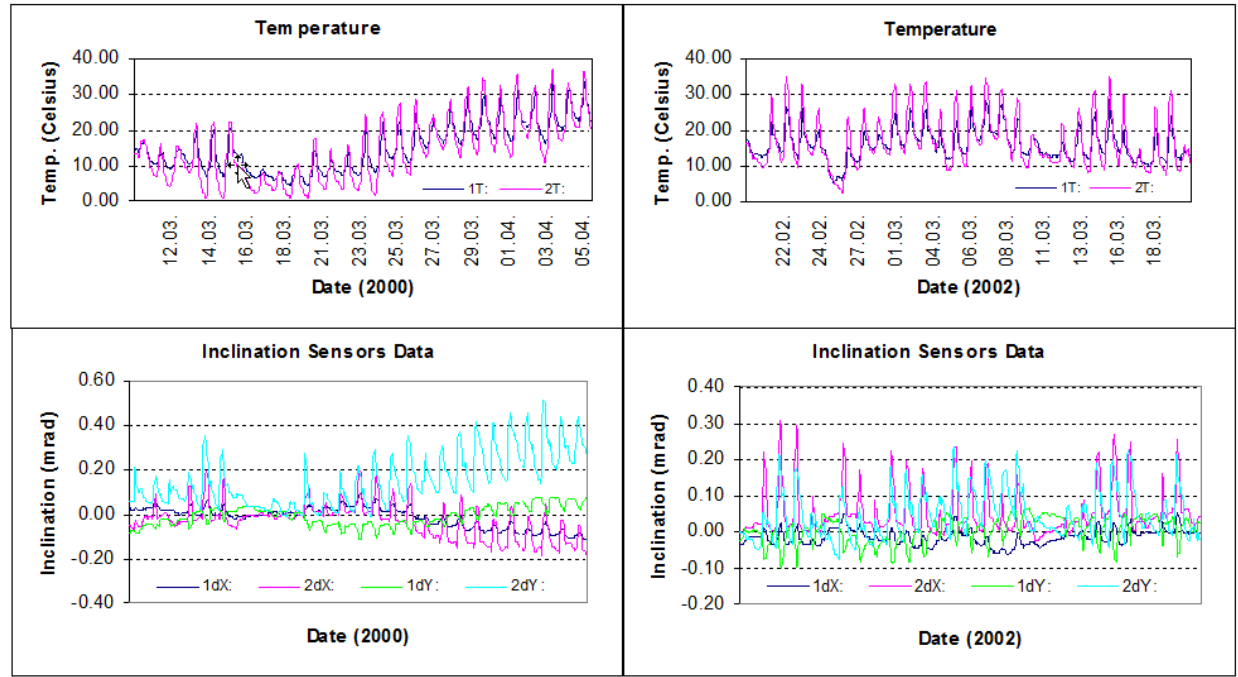
Figure 11. Temperature and inclination data of the geodetic pillar . Campaigns ran from 10 March to 6 April 2000 and from 20 February to 22 March 2002 [32].